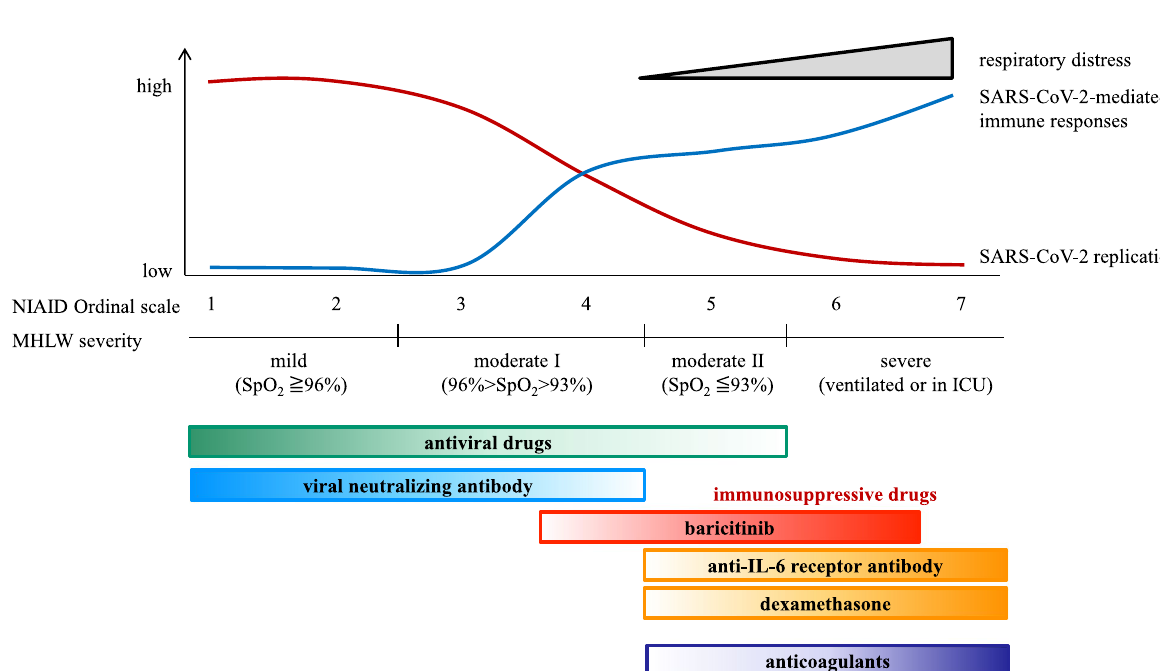
Fig. 4 Treatment strategy of Covid-19 based on disease severity. For SARS-CoV-2 infection, it is necessary to select drugs according to the disease severity and pathological condition based on NIAID ordinal scale, severity score by the Ministry of Health, Labor and Welfare, Japan and so on. Antiviral drugs and several immunosuppressive drugs should be differentially selected in each category of the